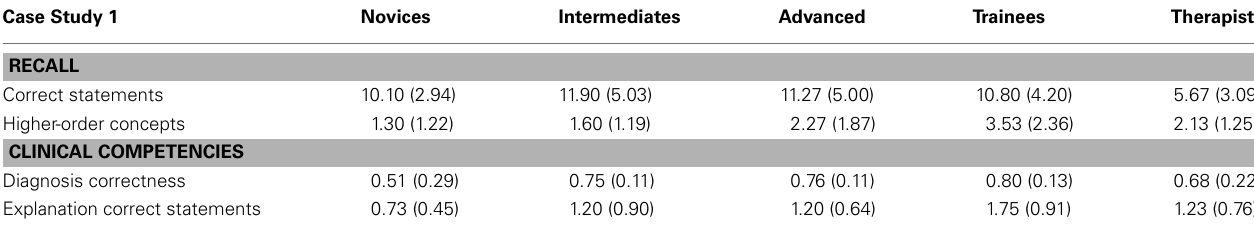
Table 2 | Means and standard deviations (in parentheses) for Case Study